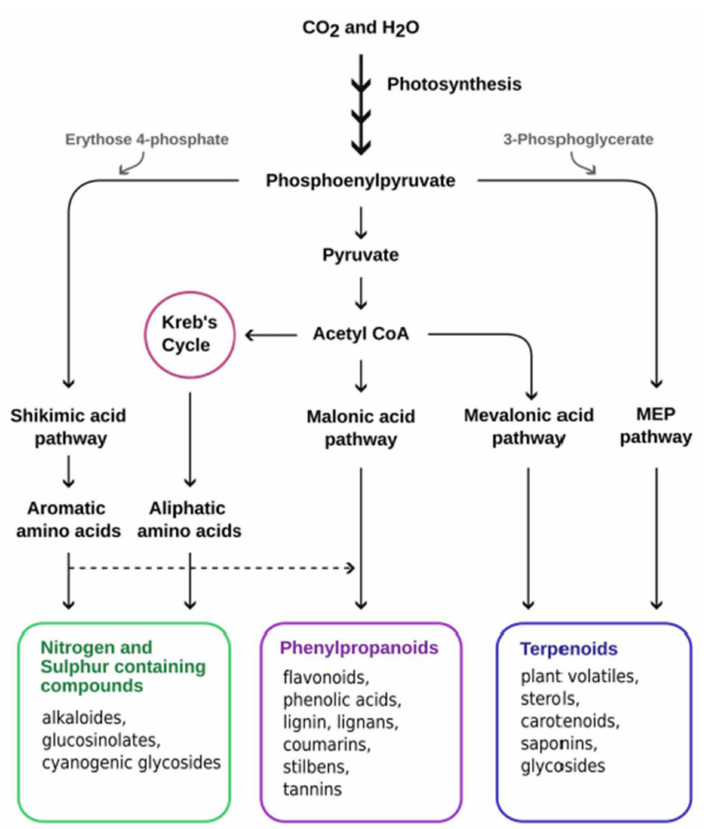
Figure 2. Schematic representation of biosynthesis of secondary metabolites (classified according to their chemical nature) required for acclimation under abiotic stress